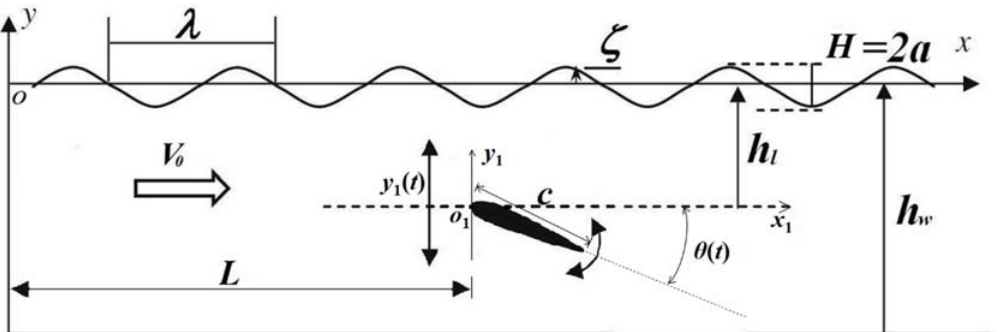
Figure 1. The scheme for an oscillating hydrofoil under a wave.